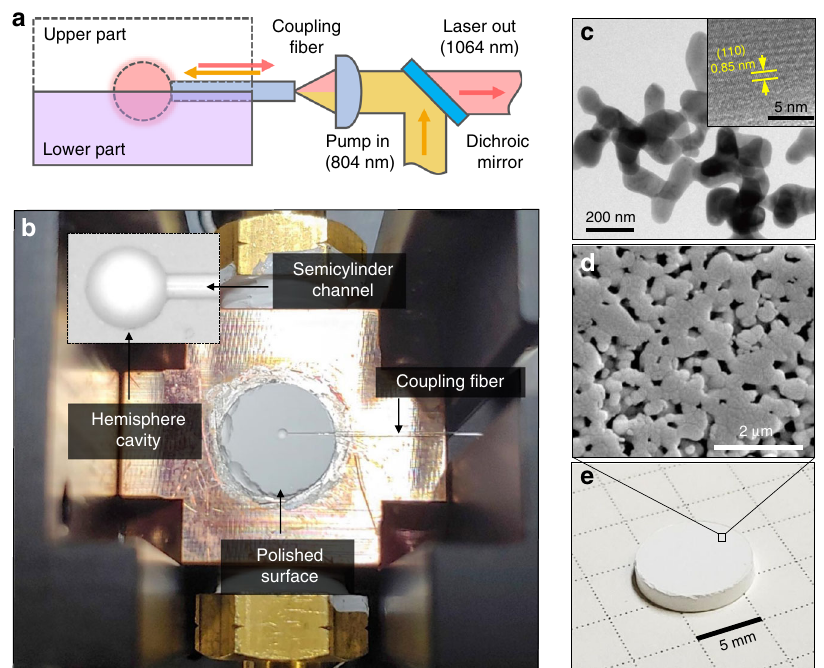
Fig. 2 Experimental setup. a Optical setup. See ‘ Methods ’ for details. b Photograph of the lower hemisphere cavity, with a cavity diameter of 800 μ m and a channel diameter of 250 μ m. The magni fi ed cavity image without the fi bre is shown in the inset. c High-resolution transmission electron microscopy (TEM) images of synthesized 1 at.% Nd:YAG nanoparticles after calcination at 1250 °C for 4 h. The inset shows the crystallinity of the particles. d Scanning electron microscopy (SEM) microstructure image of the Nd:YAG ceramics consolidated at 1350 °C for 10 h. e Porous Nd:YAG ceramic disk used as a scattering gain